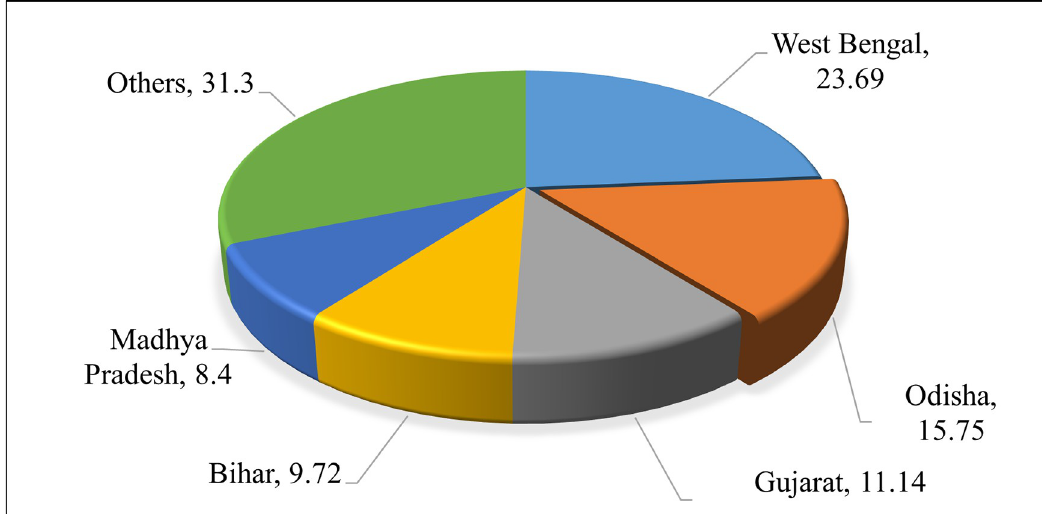
Fig 1. Percentage share of production of